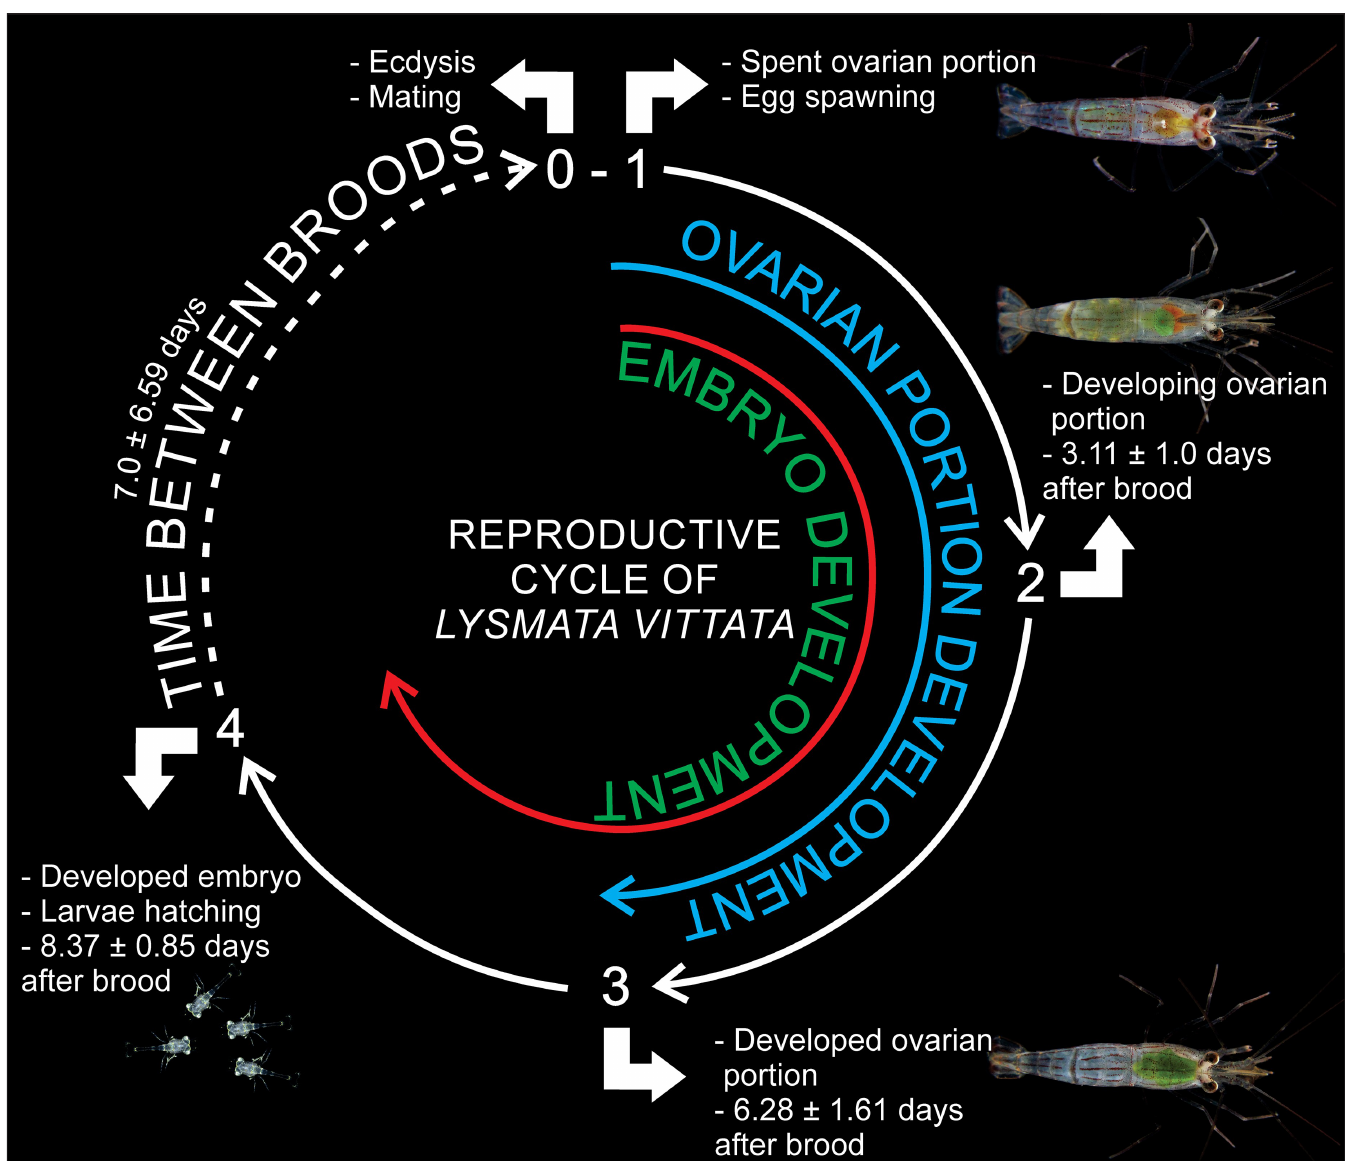
Fig 3. Reproductive cycle of Lysmata vittata (Stimpson, 1860) under laboratory conditions. The scheme shows the relationship among ecdysis, copulation, spawning and larvae hatching, based on the observation of 12 mating pairs for 70 days after three consecutive reproductive cycles.